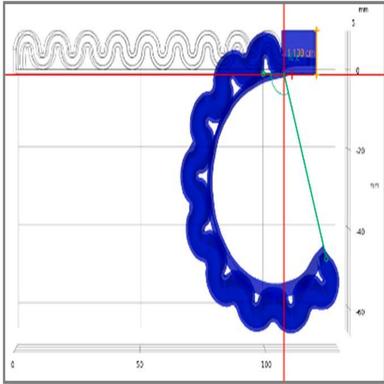
Displacement analysis (25 psi).